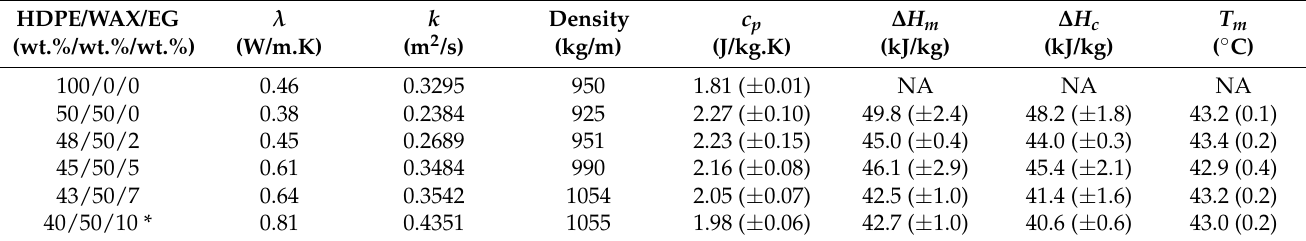
Table 1. Selected properties of SSPCMs at 22 ° C.